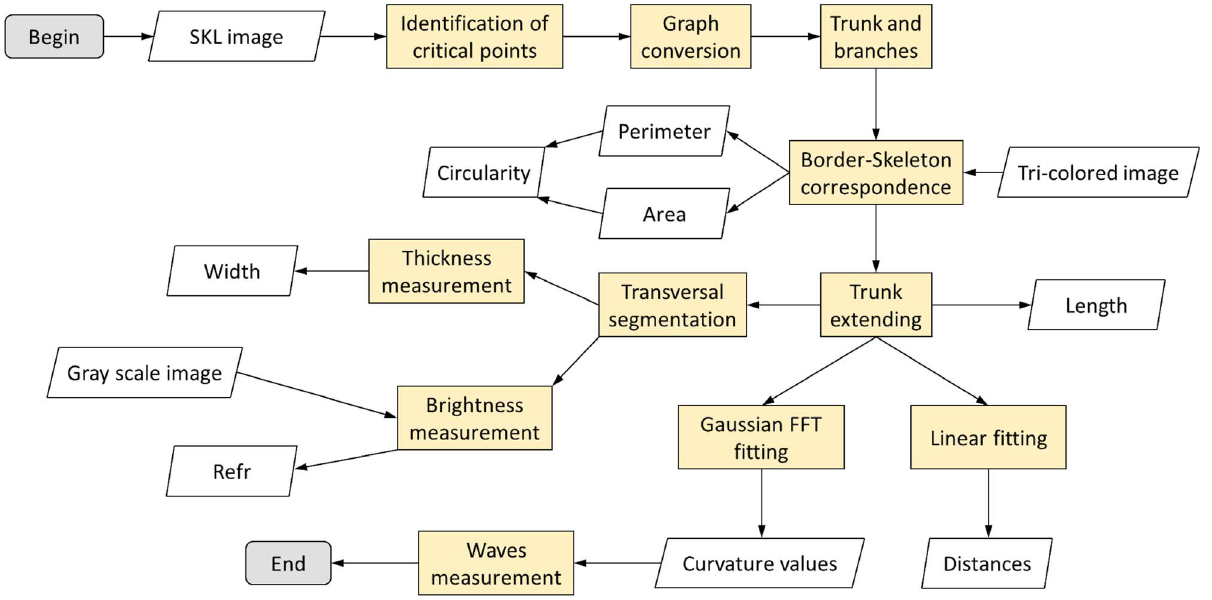
Figure 6. Flowchart of the features extraction algorithm. The SKL image, the Tri-colored image and the Gray scale image are used as input in different steps of the process (in orange) to extract the features. From this process 53 features are obtained for the statistical analysis.